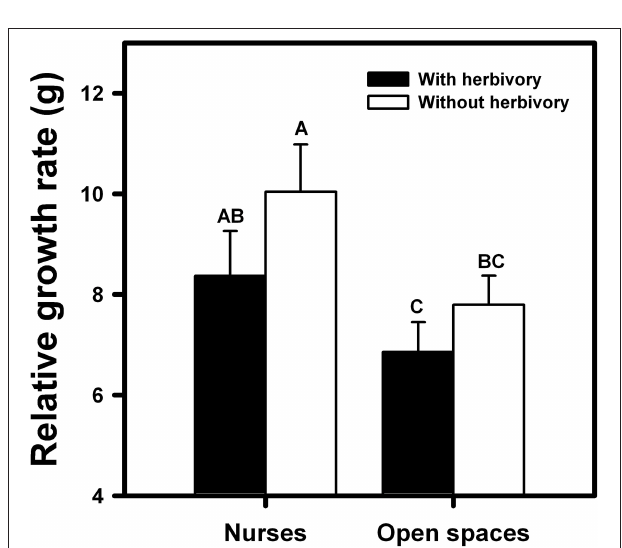
FIGURE 5 | Relative biomass of B. fimbriata rosettes in the four greenhouse treatments: nurse-like conditions with (black bar) and without (white bar) herbivory, and open spaces conditions with (black bar) and without (white bar) herbivory. Different letters indicate significant differences. Bars are means ± SE. Different letters indicate significant differences ( P < 0.01, Tukey